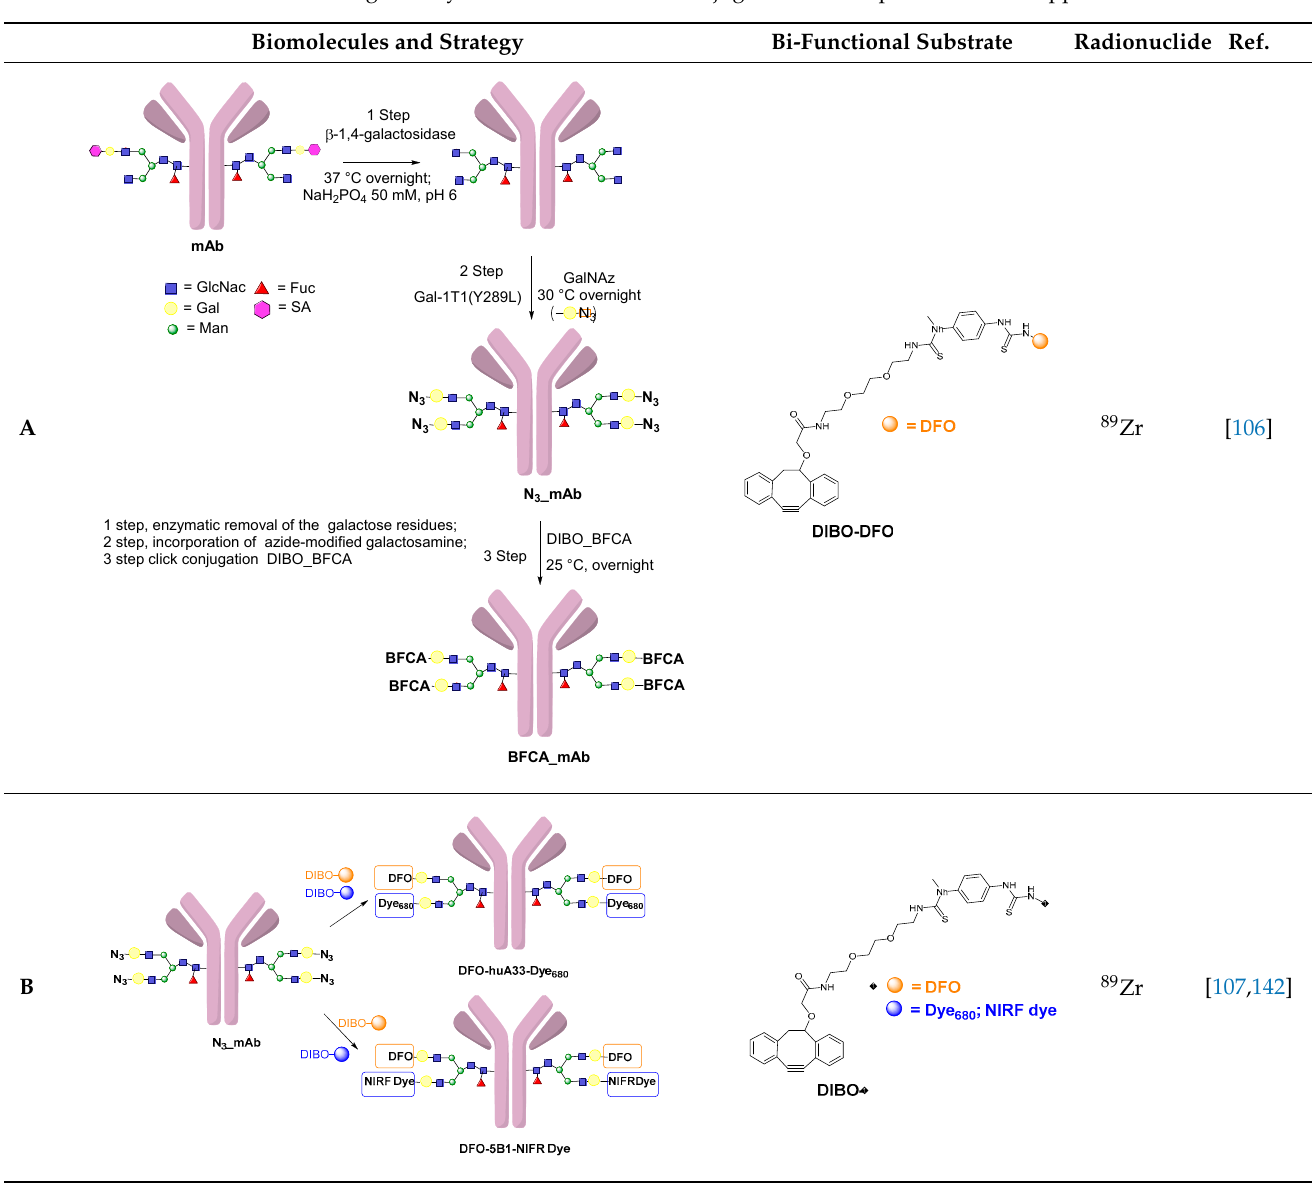
Table 7. Overview of galactosyltransferase mediated conjugation in radiopharmaceutical applications.